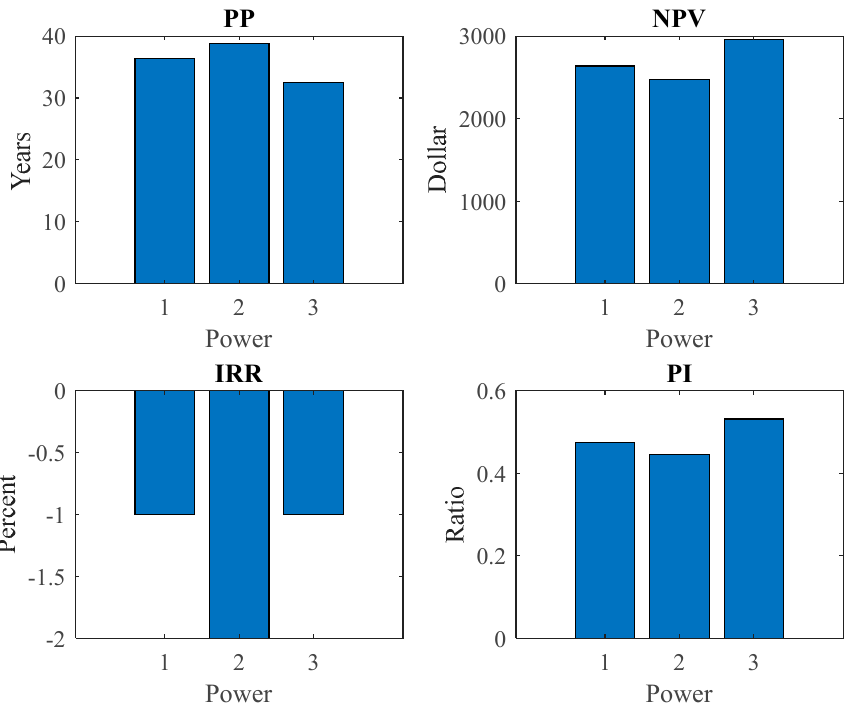
Figure 15. Comparing different buildings in the state B.